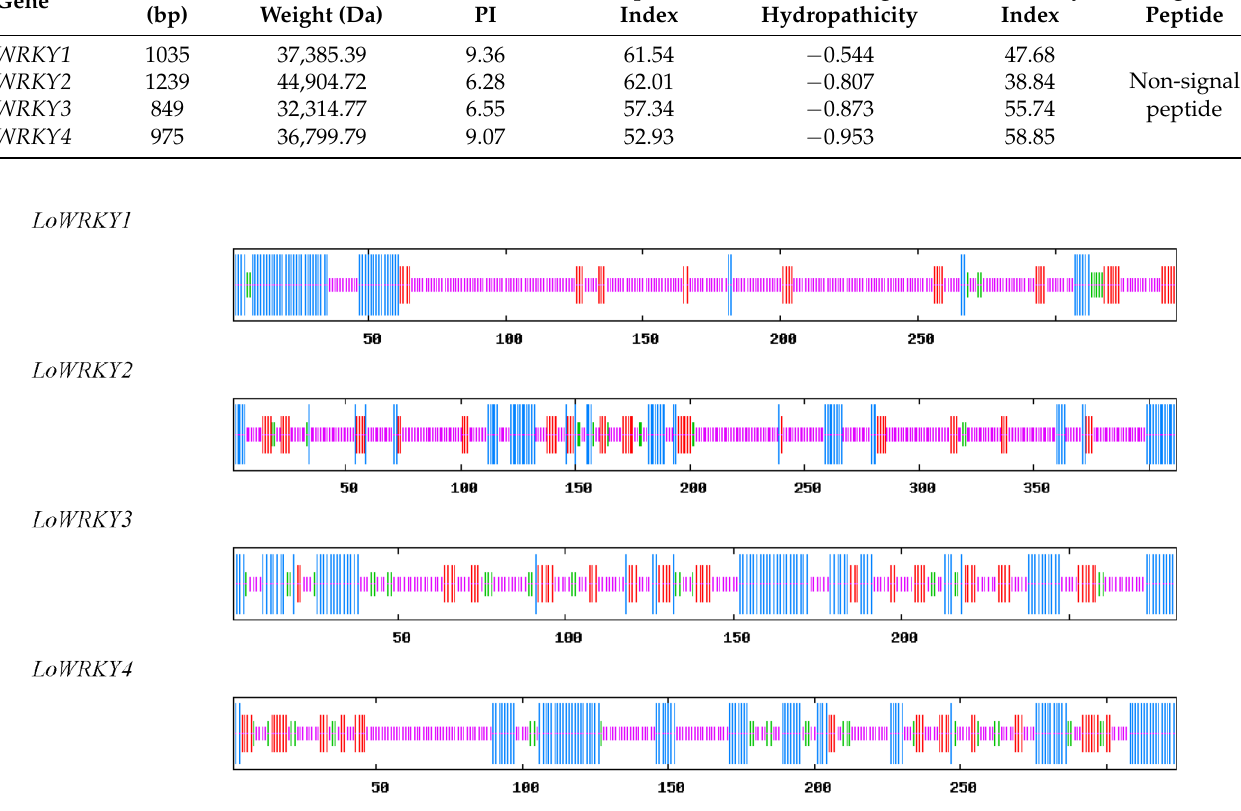
Figure 3. Predicted secondary structure of LoWRKY transcription factor family gene proteins. Note: blue: alpha helix, red: extended strand, green: beta turn, purple: random coil. Table 5. Secondary structure characteristics of LoWRKY transcription factor family gene proteins.